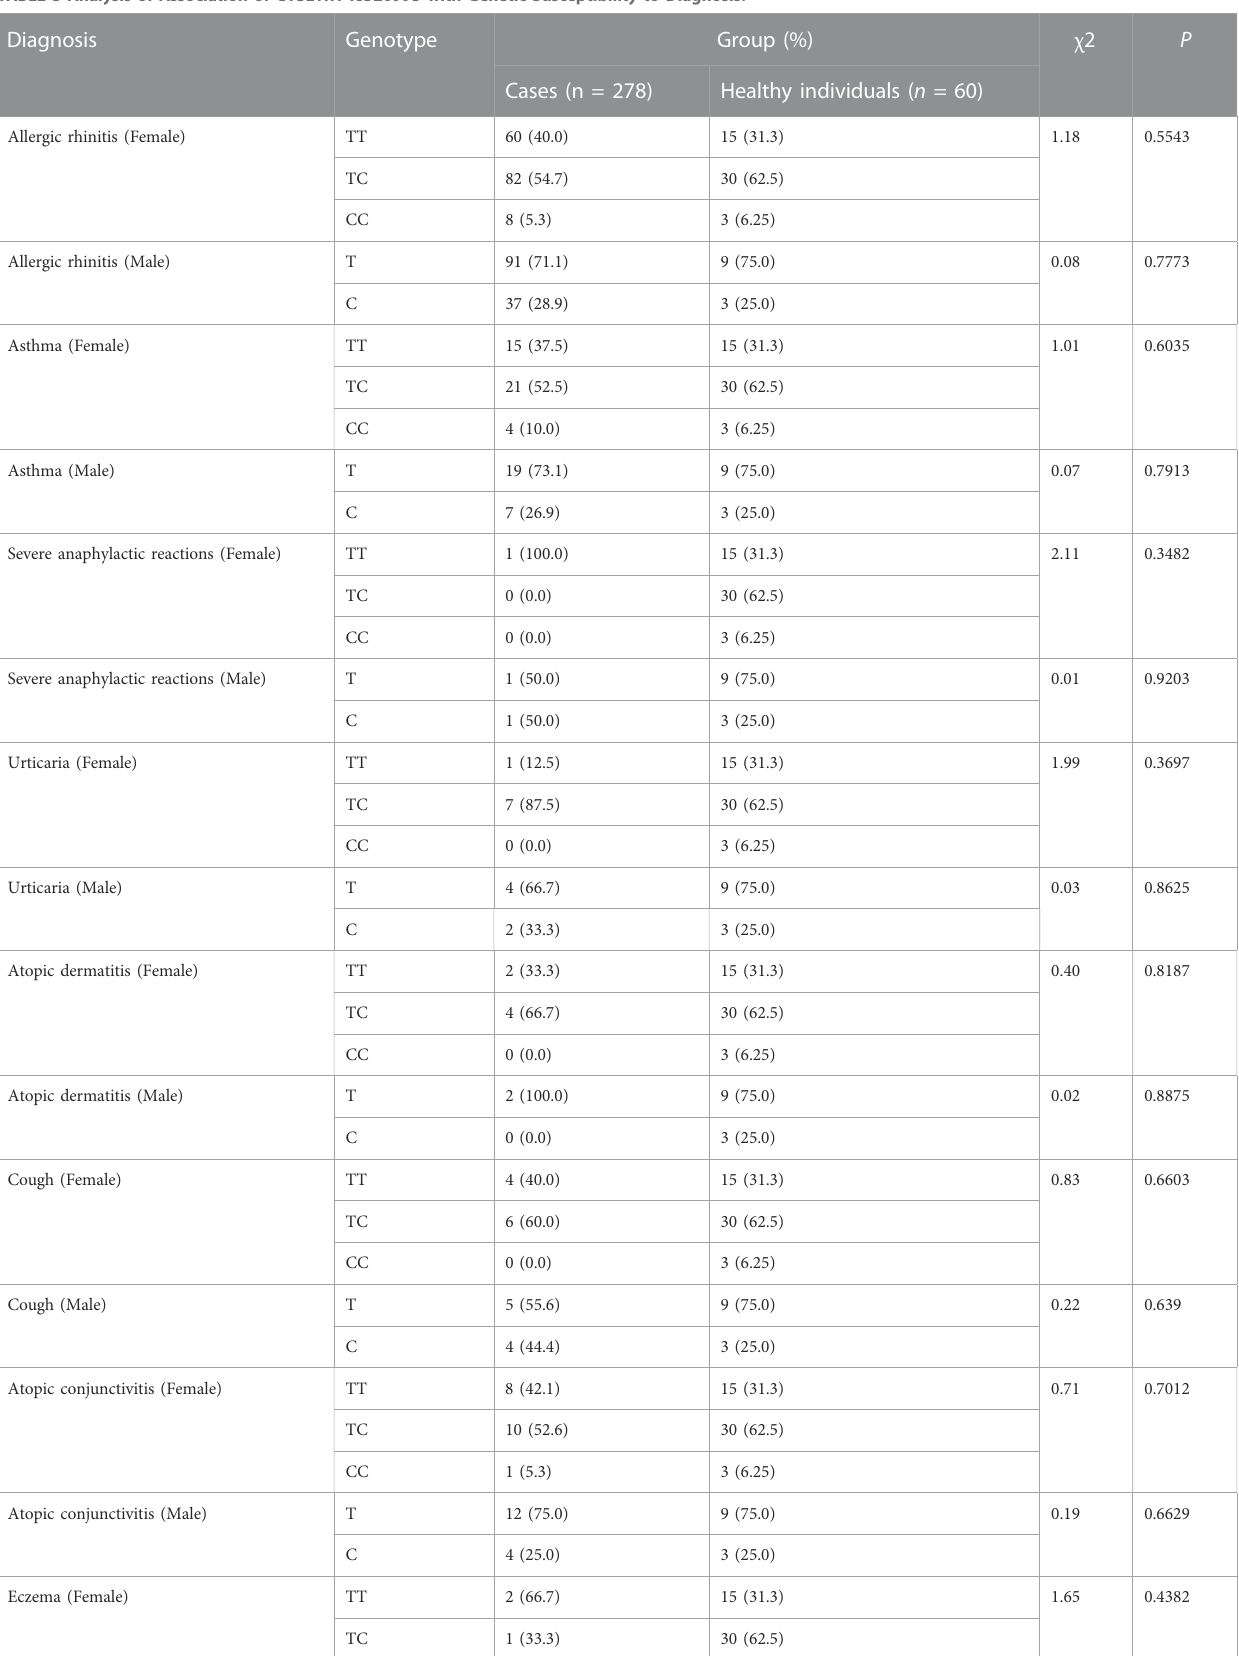
TABLE 3 Analysis of Association of CYSLTR1 rs320995 with Genetic Susceptibility to